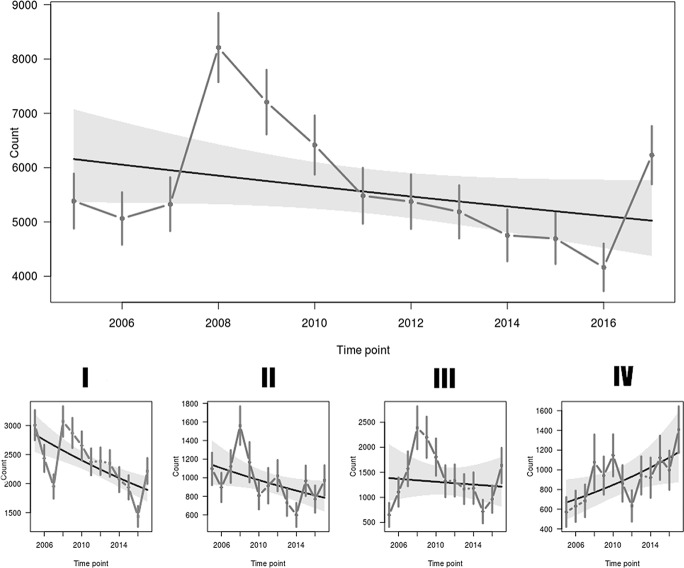
Trends in the abundance of Barbastella barbastellus
in hibernacula in Poland.Data for large hibernation sites (upper plot) and in thermal regions I-IV
(bottom plots). The overall slope and the total number of individuals
per year with their 95% confidence intervals (as shaded area and
vertical lines, respectively) are shown.